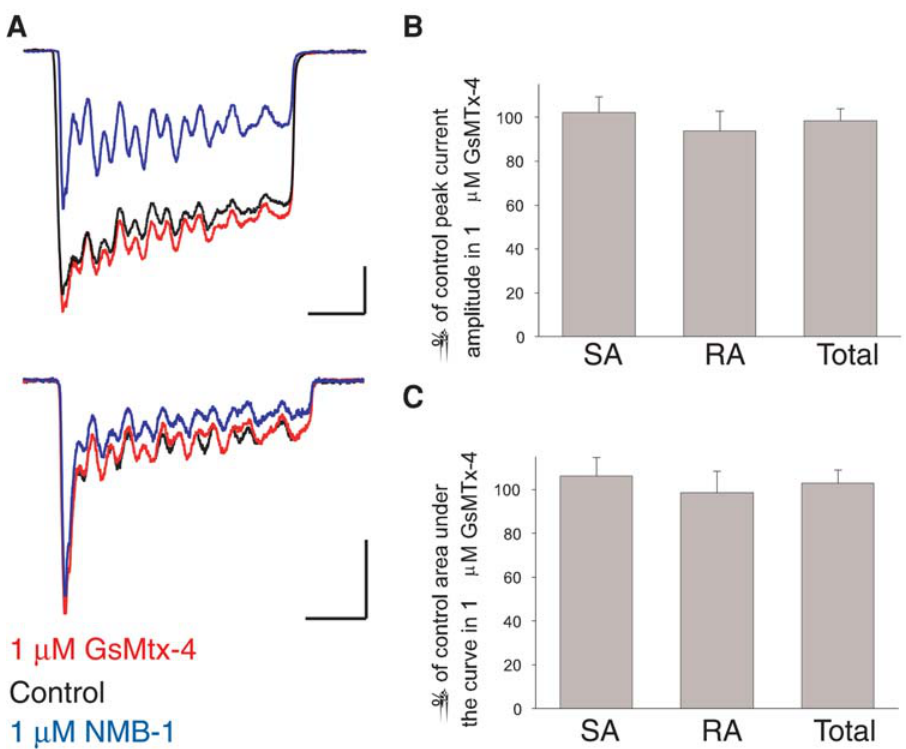
Figure 5. The stretch-activated channel blocker GsMTx-4 does not block mechanically activated currents in DRG neurons. ( A ) Example traces of SA ( top ) and RA ( bottom ) mechanically activated currents. Shown are the effects of GsMTx-4 (1 m M, red ) and for comparison, NMB-1 (1 m M, blue ). Scale bars: horizontal, 50 msec, vertical, 0.5 nA. GsMTx-4 did not significantly alter either the peak current amplitude ( B ) or the charge transfer ( C ) through DRG channels.